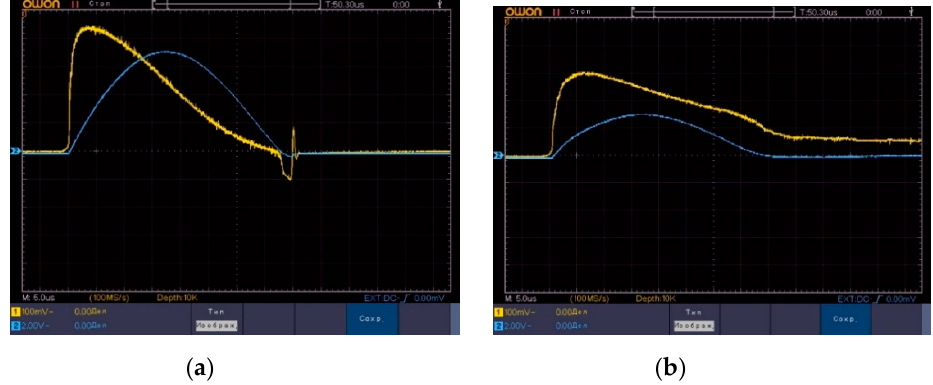
Figure 7. Oscillograms of the discharge current (blue curve) and voltage on the interelectrode gap (yellow curve) for η W ∼ 0.95 ( a ) and η W ∼ 0.8 ( b ).